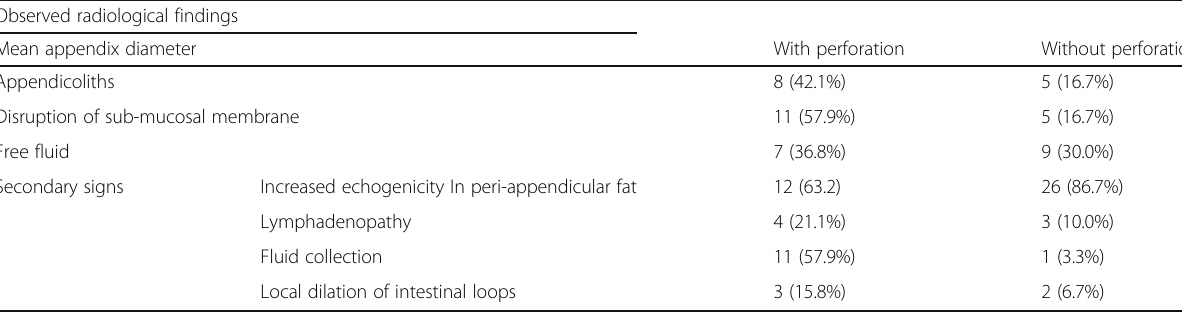
Table 2 Ultrasonography findings in patinets with appendicitis in regards to perforation status of the appendix Observed radiological